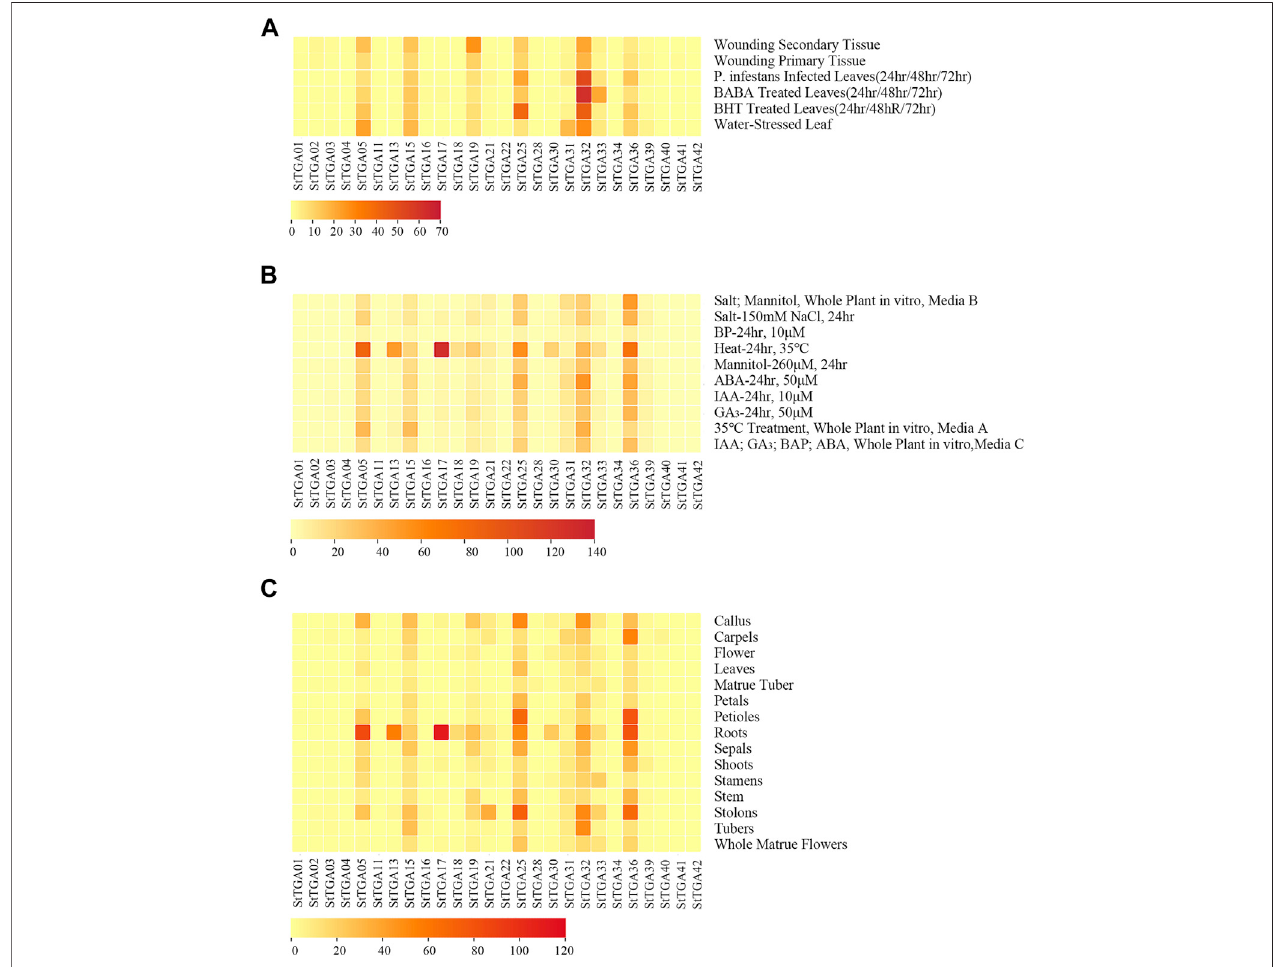
FIGURE 4 | Heat map of StTGA genes under different stresses and hormone treatments in potato. The heat map displayed the StTGA expression patterns of treatment in leaves, whole plant, or in different tissues and organs. (A) In leaves, distance values range from 0.00 to 70.00, (B) in the whole plant, distance values range from 0.00to140.00, (C) indifferenttissuesororgans indicatedtotherightoftheheatmap, distance valuesrangefrom0.00to120.00.Thegenenamesareindicatedat thebottom.Distancevaluerangeisdepictedbythegradientofcolorsrangingfromlightyellow(lowestdistancevalueindicatinghighsimilaritybetweengenomes)to red (highest distance value indicating low similarity between genomes). Stress treatment in leaves is indicated to the right of the heat map.